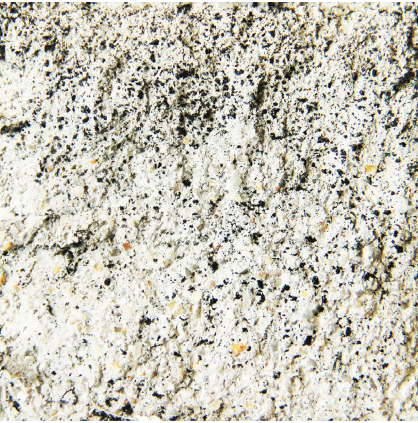
Figure 17: Profile map of K5 group with a uniformity of 0.32. The mixing amount of cellulose ether is 0 and the substitution rate of rubber is 0.25. Table 11: Relationship between substitution rate of rubber and mixing amount of cellulose ether when rubber is uniformly distributed. Level of substitution rate of rubber Level of mixing amount of cellulose ether Substitution rate of rubber 0.00 Mixing amount of cellulose ether